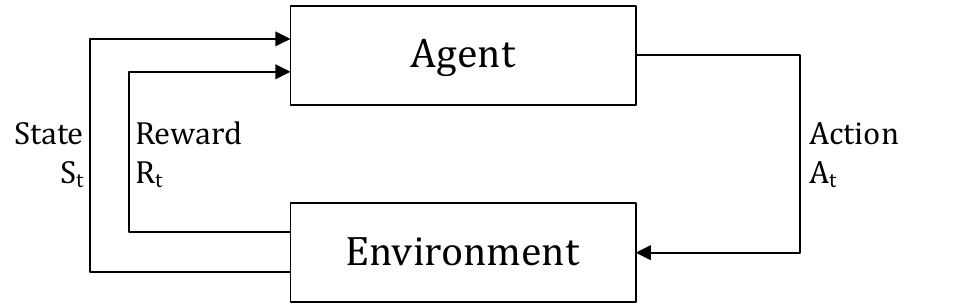
Figure 1. Schematic agent—environment interaction within a reinforcement learning (RL) algorithm, adapted from